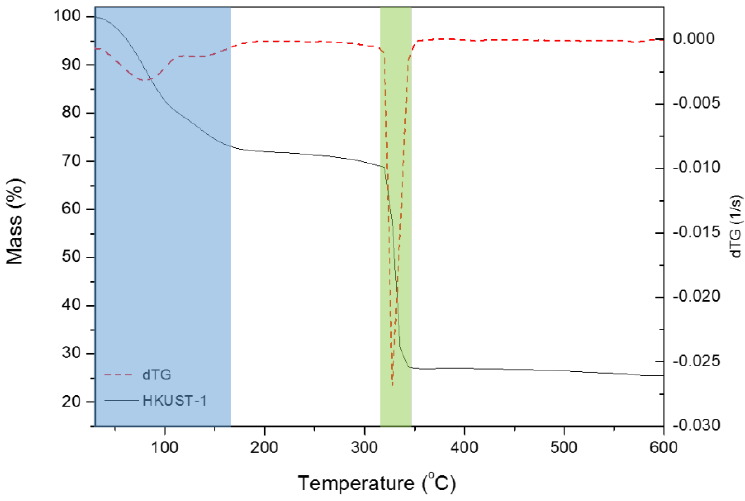
Figure 1. Thermogravimetric curves of HKUST-1.